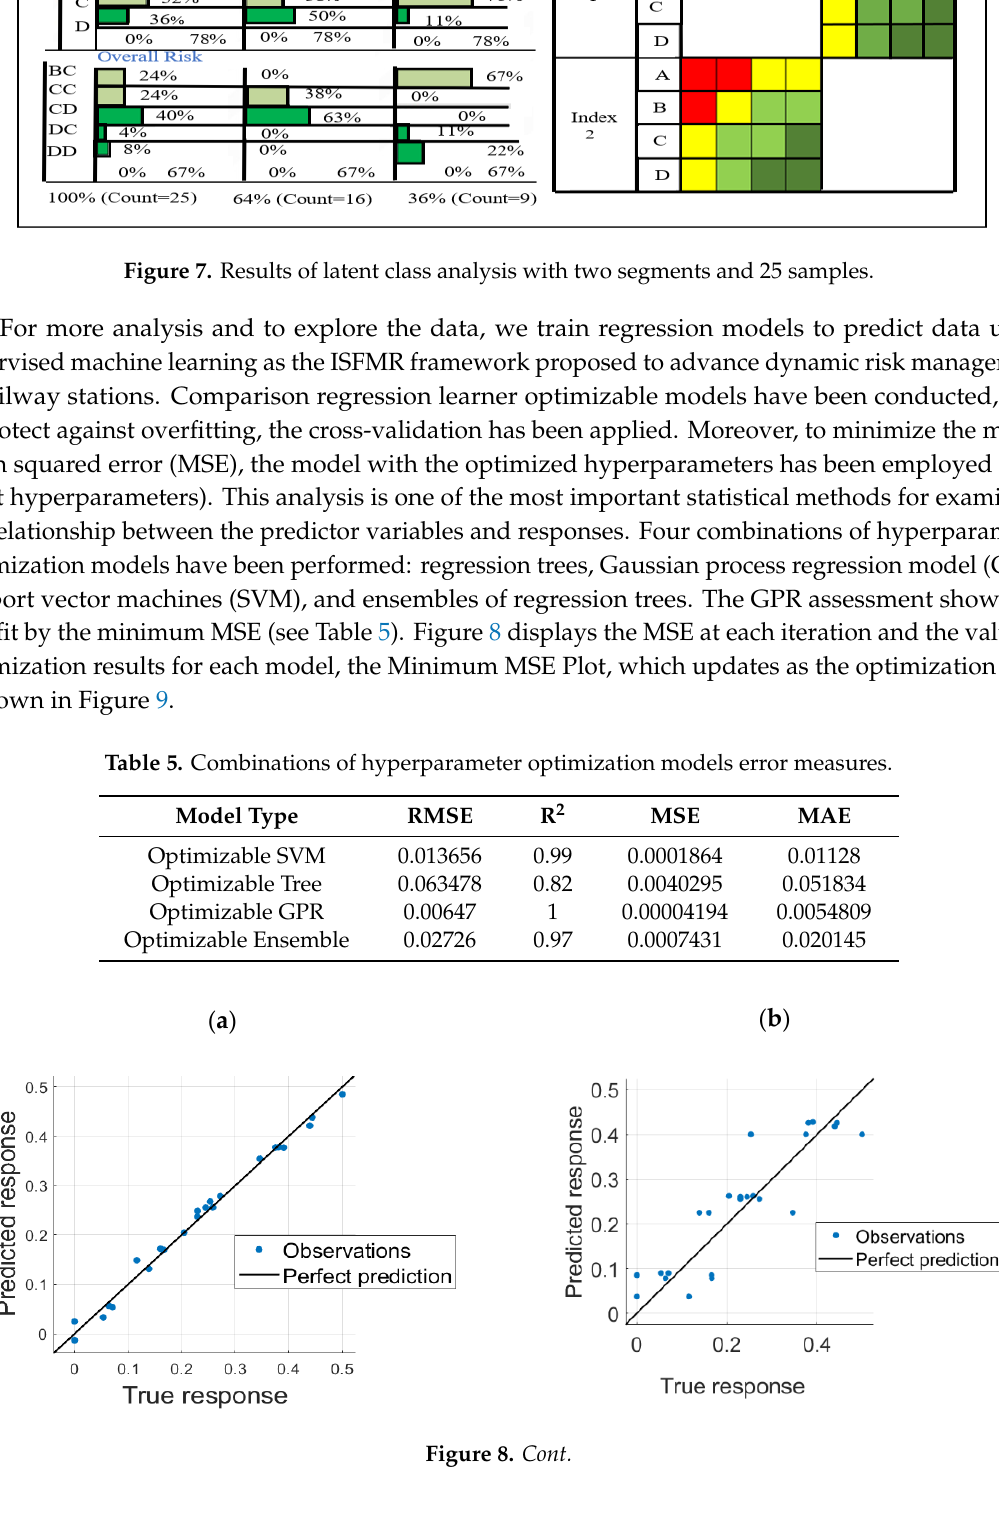
Figure 7. Results of latent class analysis with two segments and 25 samples.